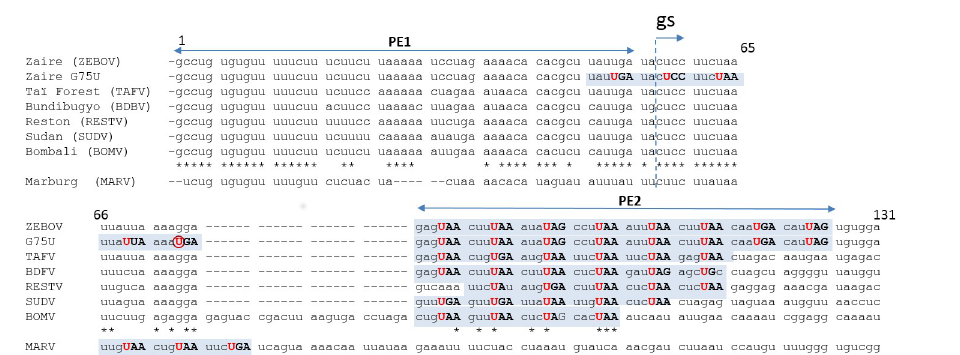
Fig 1. Filovirus bipartite promoters. This alignment of the EBOV/U7 genome 3 0 ends is based on the premise that genomes are assembled directly from their 5 0 ends, 6 nt/NP protomer, generating genome hexamer phase where only nt in hexamer positions 3, 4, and 5 point away from the protein core and can readily interact with the polymerase (underlined below). At least for ZEBOV, sequences upstream of the editing site will have different hexamer phases, e.g., 3 0 NNN U RR for EBOV/U7 and 3 0 NN U RRN for EBOV/U8 for the PE2 repeats. The conserved 3 0 URR of contiguous PE2 repeats (shaded in blue) is capitalized. The conserved U of the repeat is highlighted in red and that of G75U is circled, and asterisks below the EBOV sequences indicate their overall sequence conservation. MARV, aligned below, does not appear to have any spacer region between gs (indicated by bent arrow) and the 3 PE2 repeats. Only the ZEBOV and MARV PE2 repeats have been experimentally verified [23]. BDBV, Bundibugyo virus; BOMV, Bombali virus; EBOV, Ebola virus; gs, gene start; MARV, Marburg virus; NP, nucleoprotein; nt, nucleotides; PE1, promoter element 1; PE2, promoter element 2; RESTV, Reston virus; SUDV, Sudan virus; TAFV, Tai Forest virus; ZEBOV, EBOV